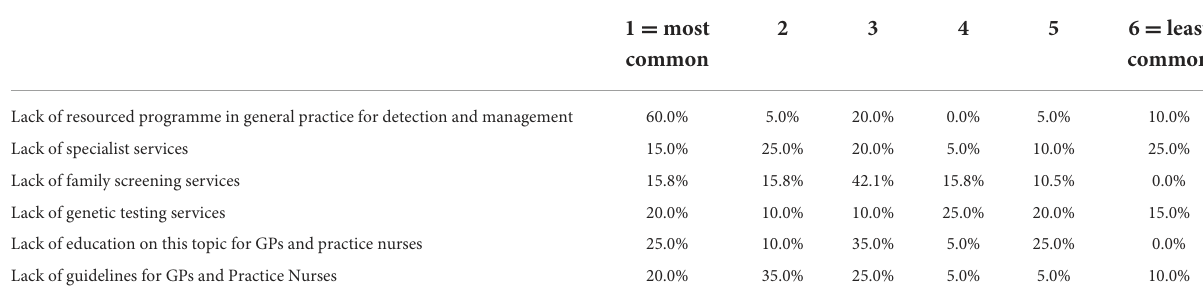
TABLE 5 Common barriers to the detection and management of FH.